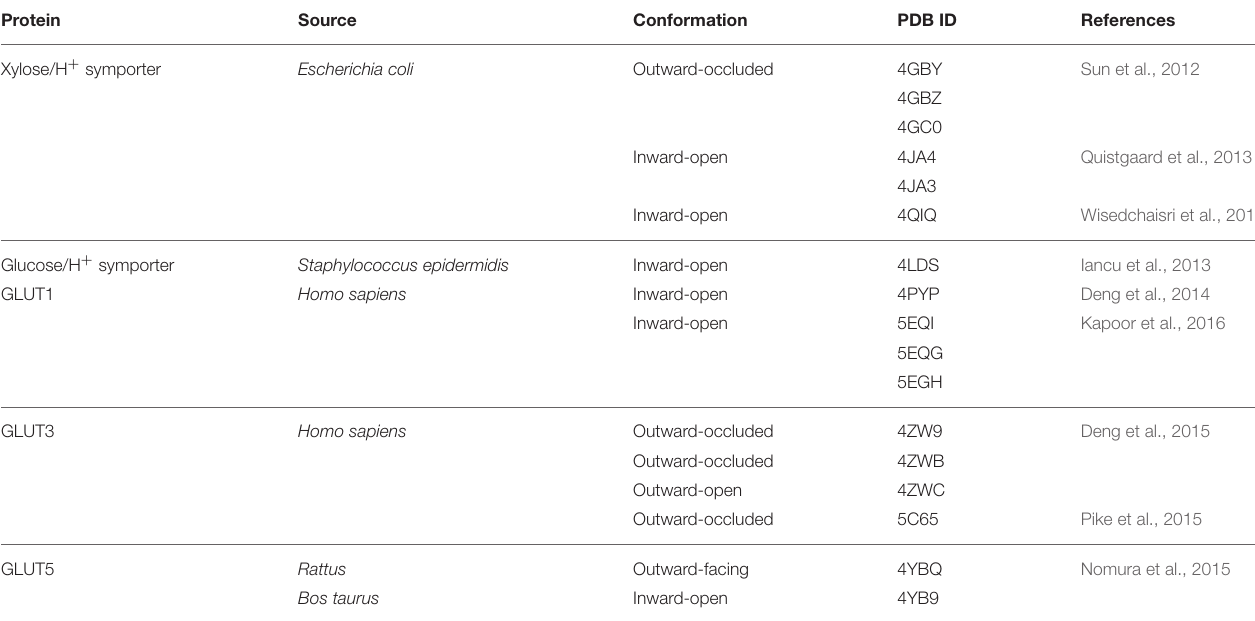
TABLE 1 | Crystal structures of GLUTs and their homologs.